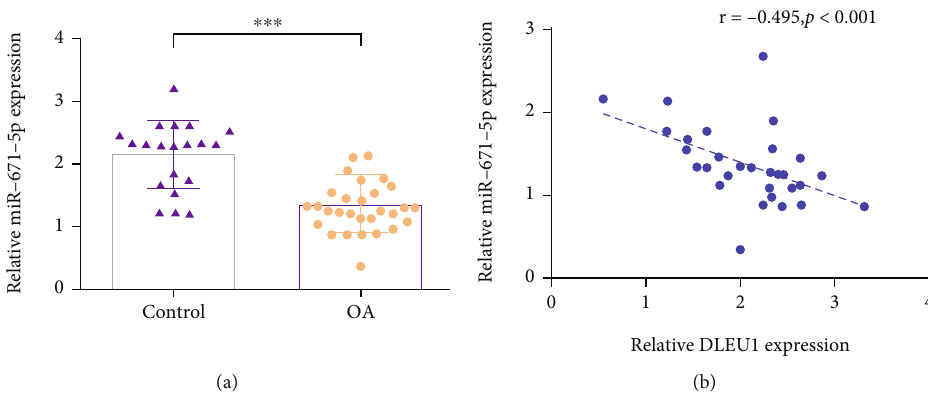
Figure 3: miR-671-5p was decreased in OA specimens. (a) The miR-671-5p expression in the control cartilages and OA cartilages was detected by qRT-PCR assay. (b) There was a negative correlation expression between miR-671-5p and DLEU1 in OA specimens. ∗∗∗ p < 0 : 001